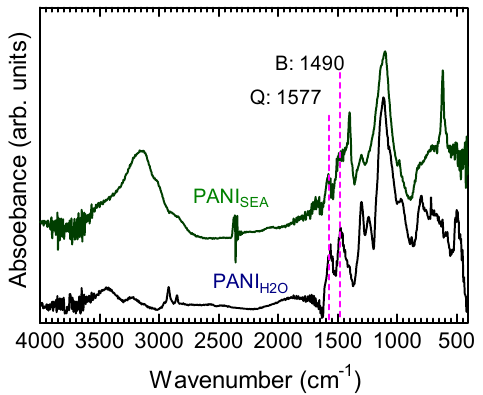
Figure 2. FT–IR spectra of the samples prepared using seawater as the solvent (polyaniline prepared in seawater, PANI SEA ) and the standard PANI (polyaniline prepared in distilled water, PANI H2O ) prepared using pure water as the solvent.